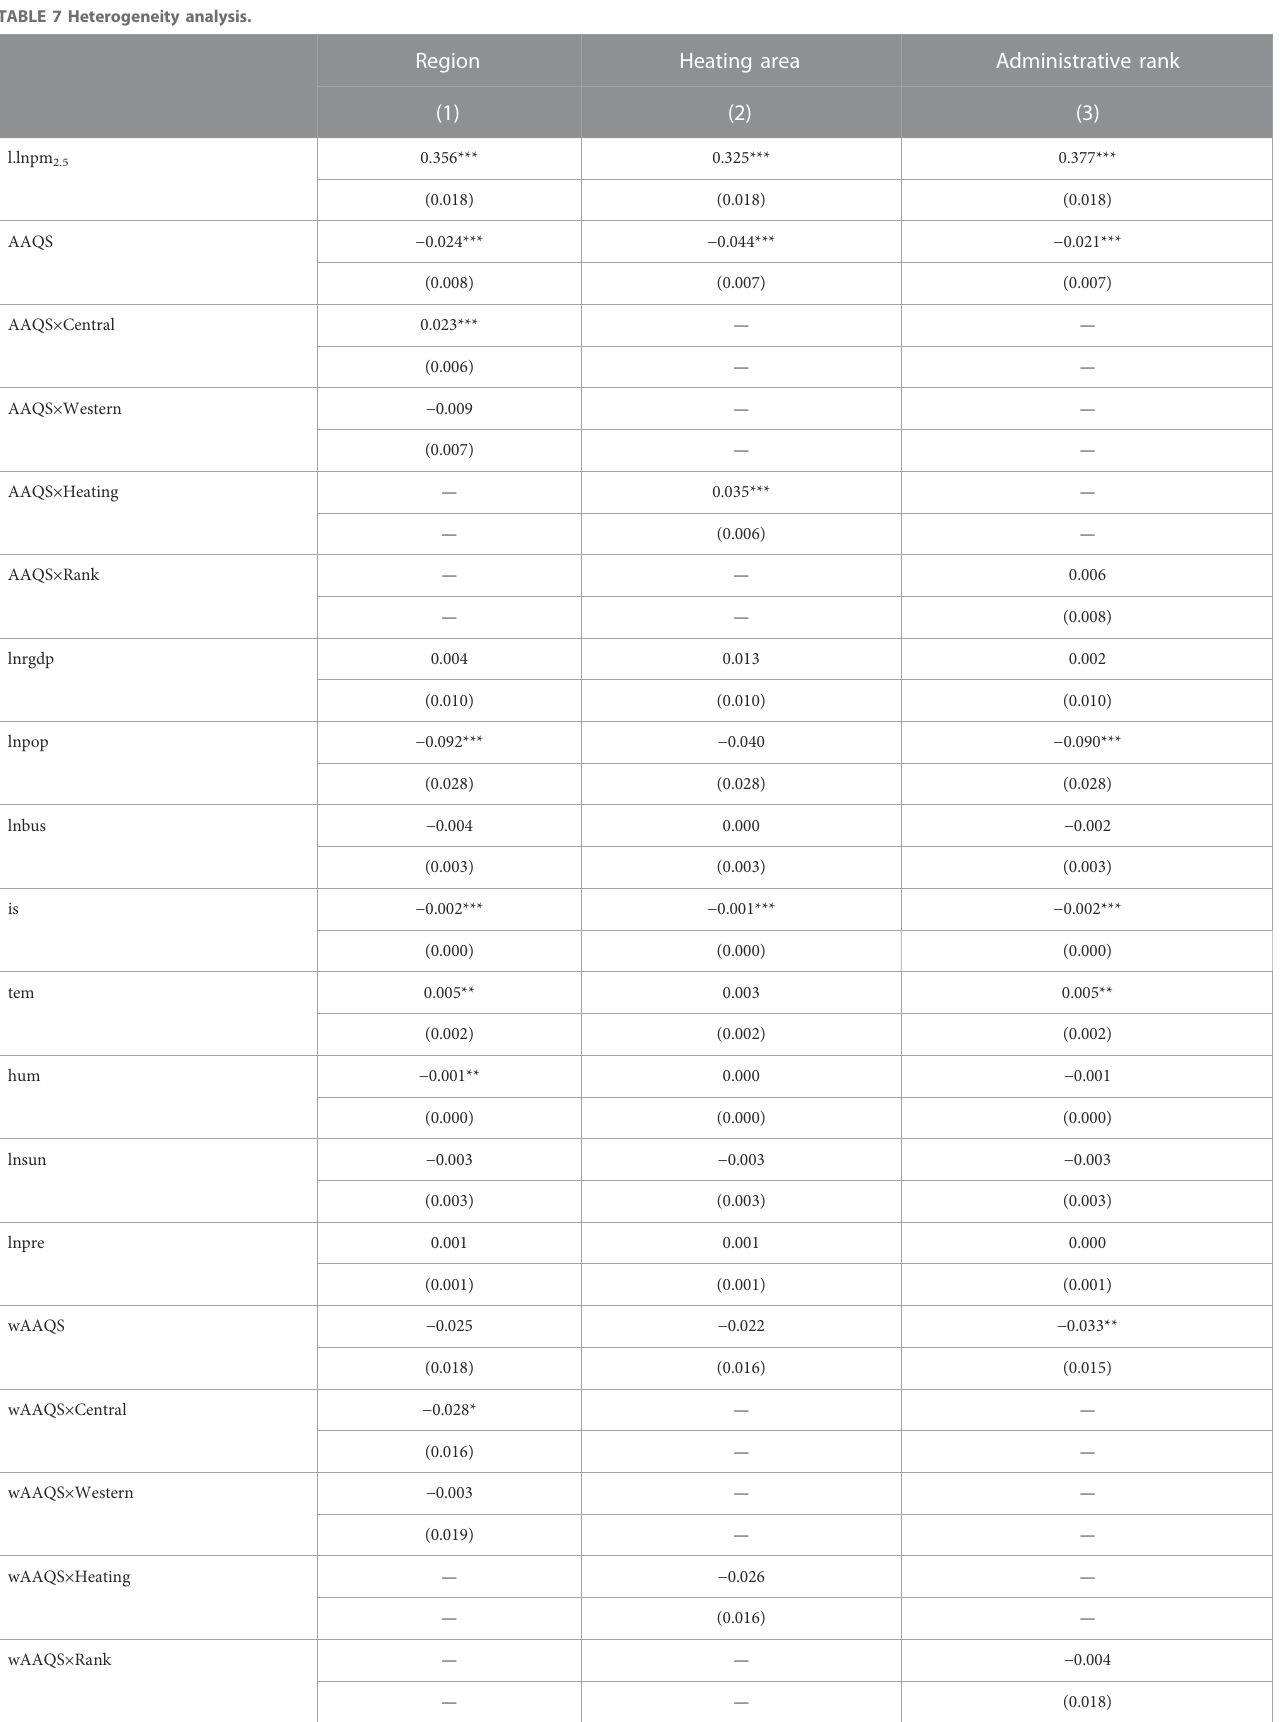
TABLE 7 Heterogeneity